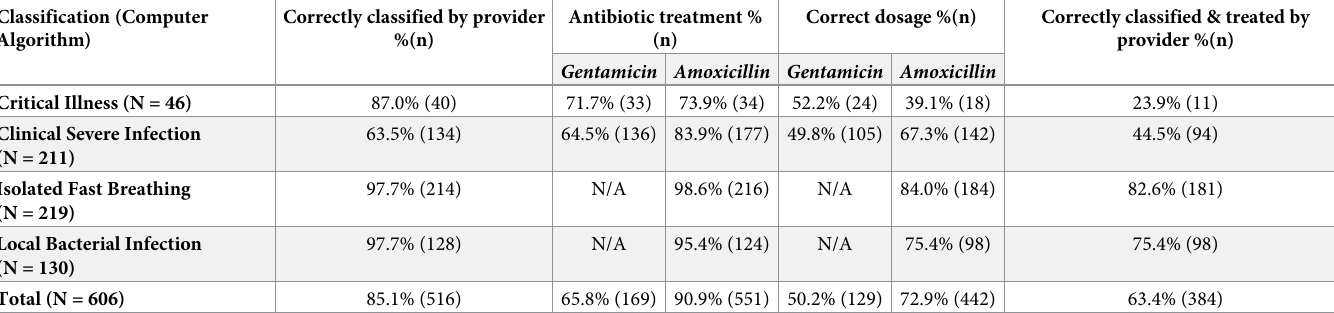
Table 5. Classification and treatment of young infants with signs of possible bacterial infection by providers. Classification (Computer